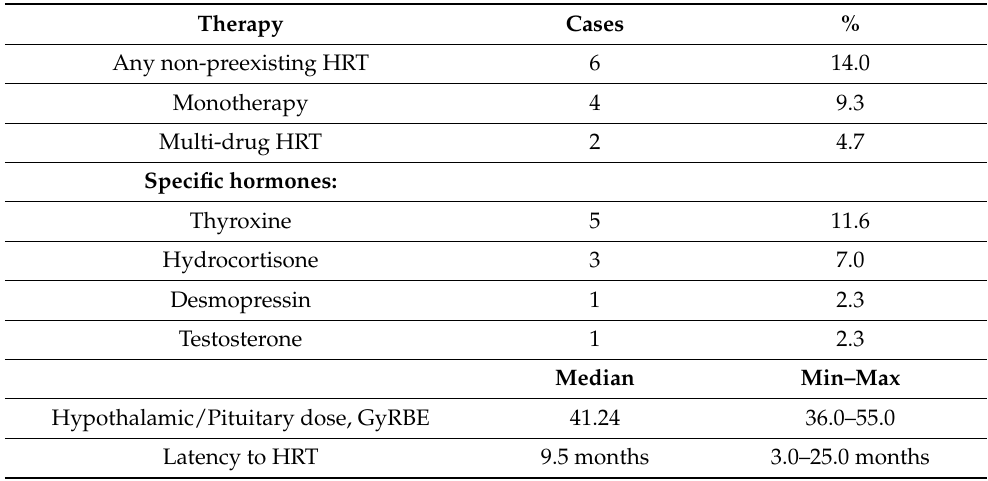
Table 5. Preliminary data on neuroendocrine deficiency.